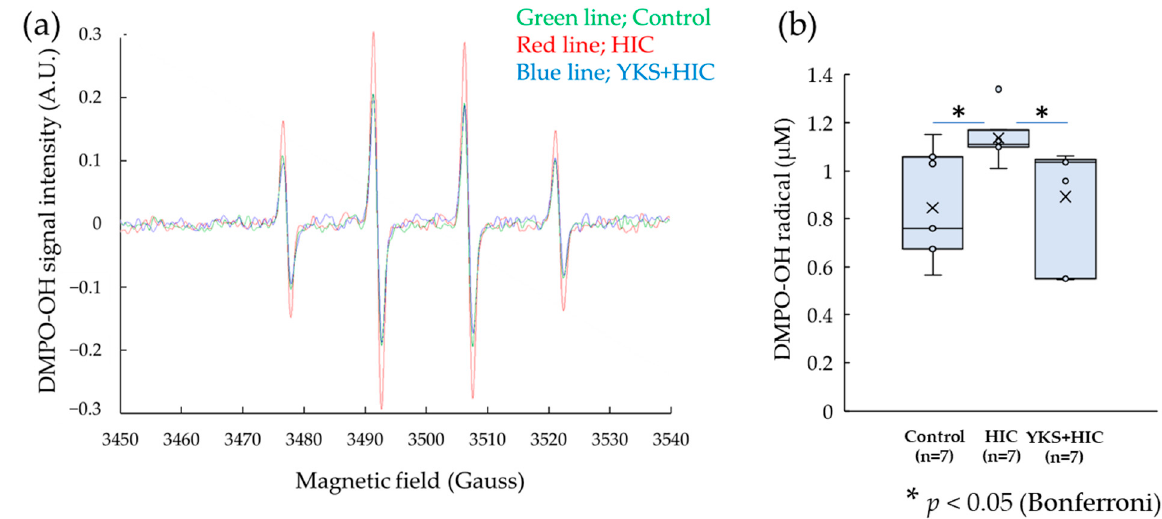
Figure 4. DMPO-OH radical. ( a ) DMPO-OH signals detected by ESR. ( b ) the intensity of the DMPO- OH signal. Horizontal lines within boxes denote median values, and × marks denote the mean values. ·OH significantly increased in the HIC group compared with the control group; however, the increase was significantly suppressed by the administration of YKS. * Significant difference ( p < 0.05) (Kruskal–Wallis test with the post hoc test and Bonferroni correction). HIC, Hunner type interstitial cystitis; YKS, Yokukansan; DMPO, 5,5-dimethyl-1-pyrroline-N-oxide; ·OH; Hydroxyl rad- ical.